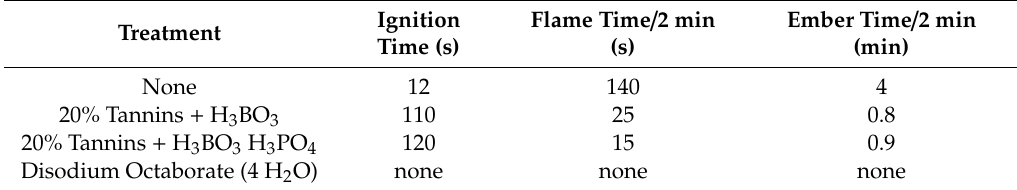
Table 12. Ignition and ember time results